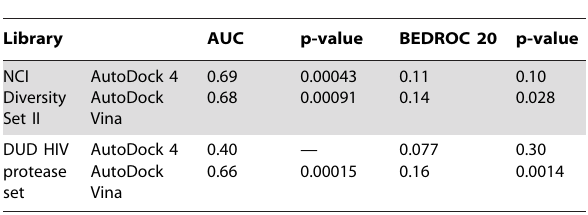
Table 1. Virtual screen